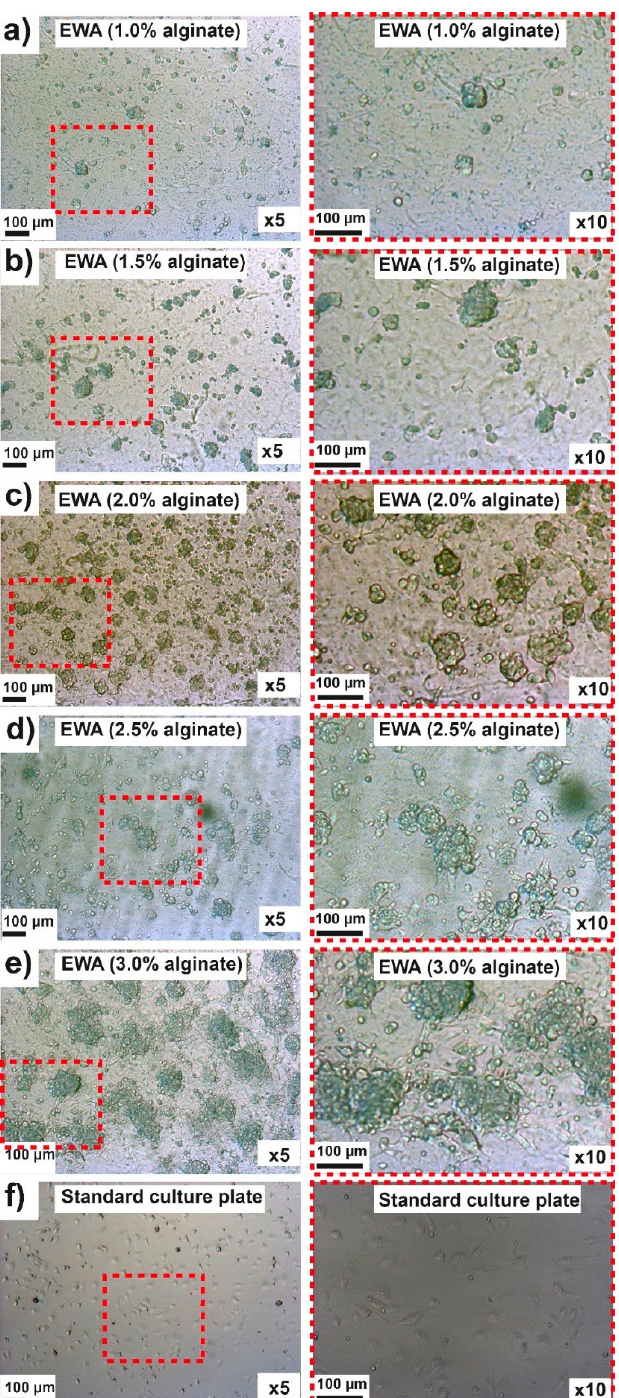
Figure 4. Optical images of NS-SV-AC cells growing on EWA hydrogels at day 3 after culture . Cells were seeded on top of the EWA at various concentrations of alginate: 1.0% ( a ), 1.5% ( b ), 2.0% ( c ), 2.5% ( d ) or 3.0% ( e ); as control, cells were seeded on a standard culture plate ( f ). Magnification ×5 (left panel) and ×10 (right panel). Scale bar 100 µm. Red dotted lines show the area of the magnified images.